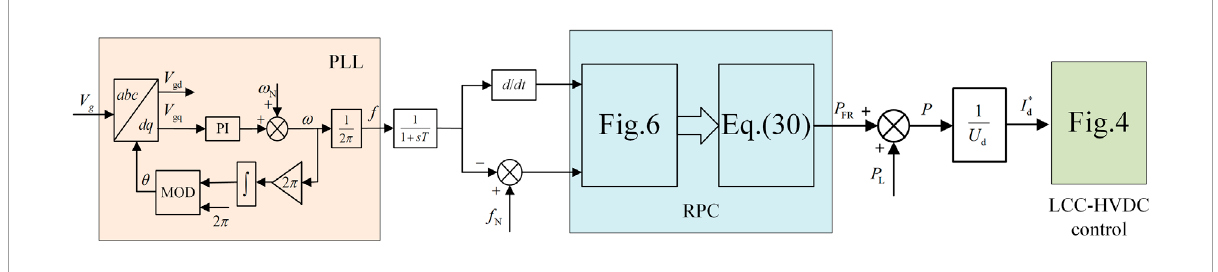
FIGURE 9 Proposed frequency control scheme for sending end of LCC-HVDC system.